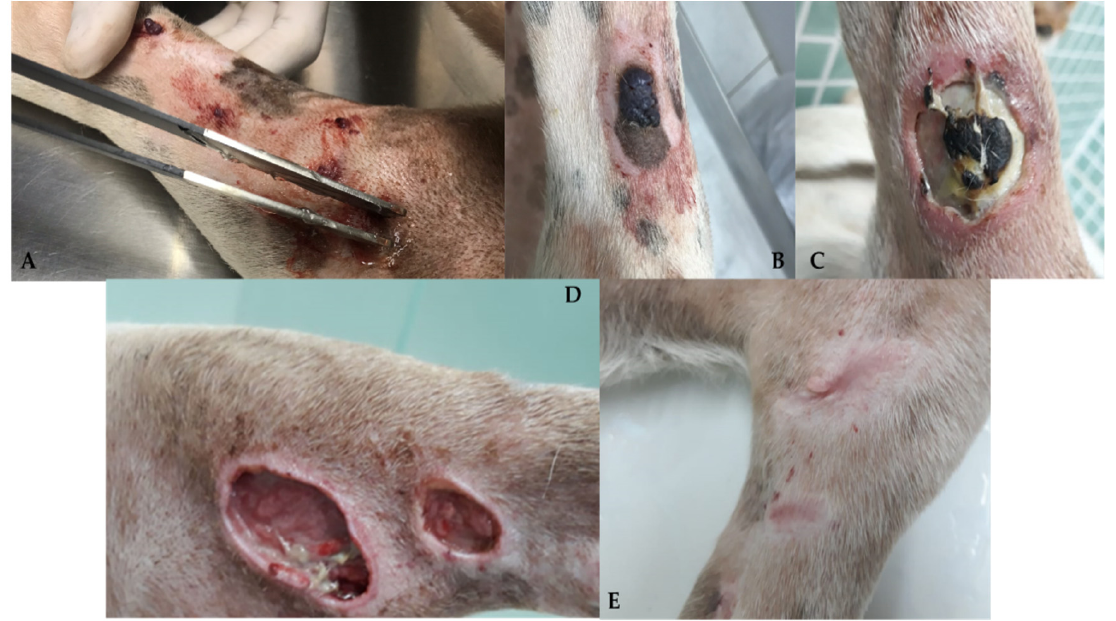
Figure 5. Canine patient diagnosed with multiple cutaneous HSA who underwent ECT with sys- temic BLM. Multiple skin lesions are observed in the region of the pelvic limb ( A ). Crust and ulceration 7 days after ECT ( B , C ). Necrosis and tissue loss 15 days after ECT ( D ). Complete remission 30 days after ECT with areas of scar tissue ( E ).